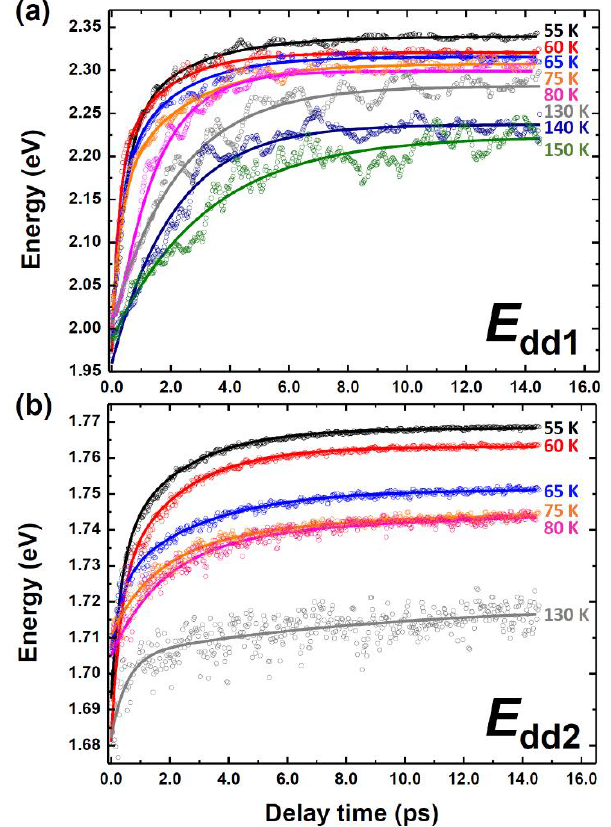
Figure 3. Time evolution of Mn 3+ on-site d-d transition of ( a ) E dd1 ( e 1g → a 1g ) and ( b ) E dd2 ( e 2g → a 1g ) at different temperatures.